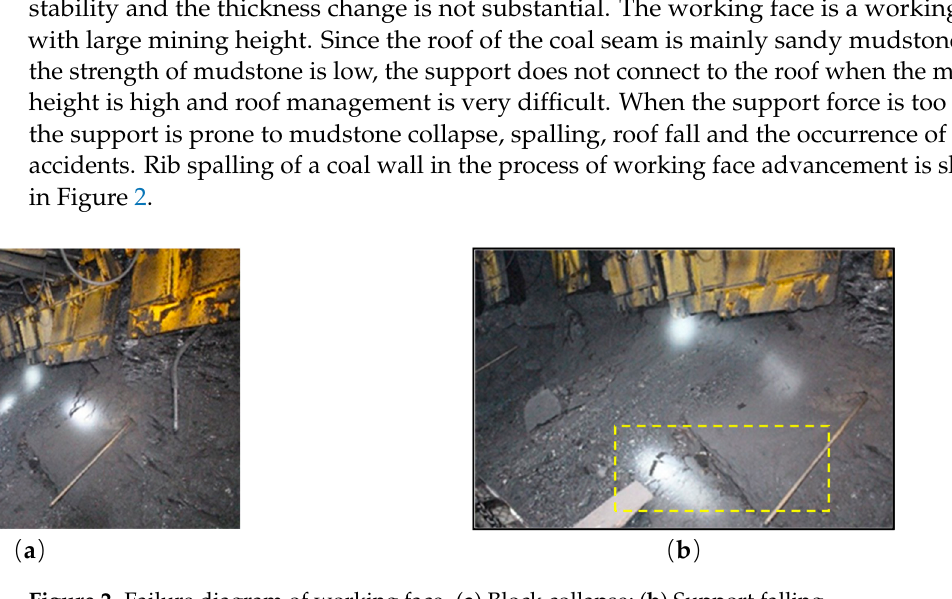
Figure 1. 150505 working face layout relationship and comprehensive histogram.